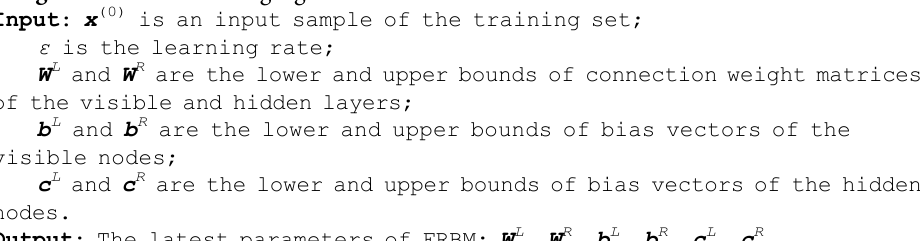
Algorithm 1 The learning algorithm of